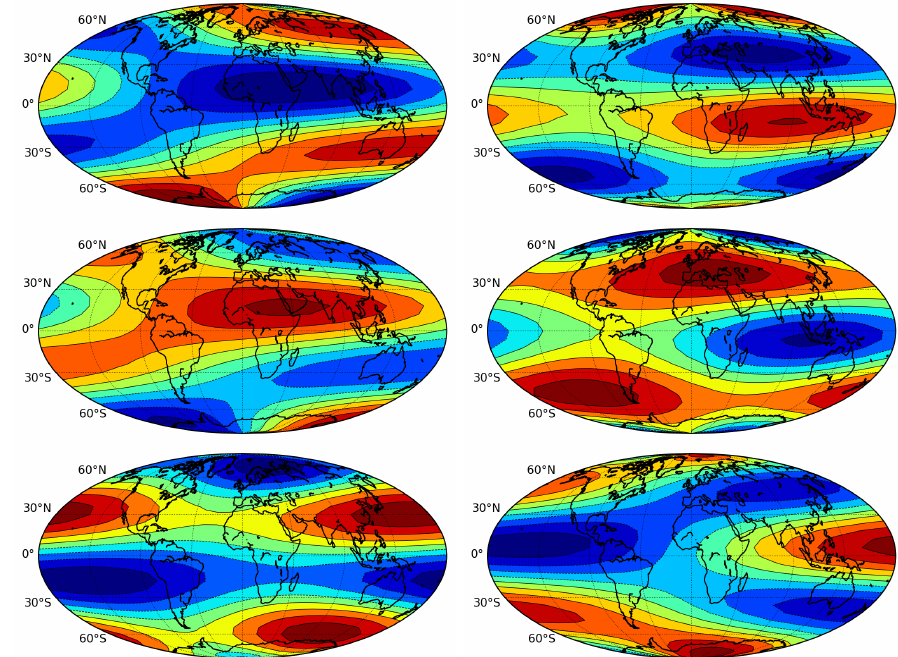
Figure 15. Pattern functions of the LIGO Hanford (first line), LIGO Livingstone (second line) and Virgo detector (third line) as a function of right ascension and declination at the time of GW170817: 17 August 2017, 12:41:53 UTC. The first and second column represent respectively F + and F , the position of × the GW170817 source being right ascension = 13 h 09 (cid:48) 48 (cid:48)(cid:48) , declination = 23 ◦ 22 (cid:48) 53 (cid:48)(cid:48) . Pattern function − F 2 + + F 2 values range from 1 (dark red) to 1 (dark blue). The values of for LIGO Hanford,LIGO − × Livingstone and Virgo are respectively 0.89, 0.75, 0.30 at the location and time of GW170817. Computed (cid:113) via the LALSuite library